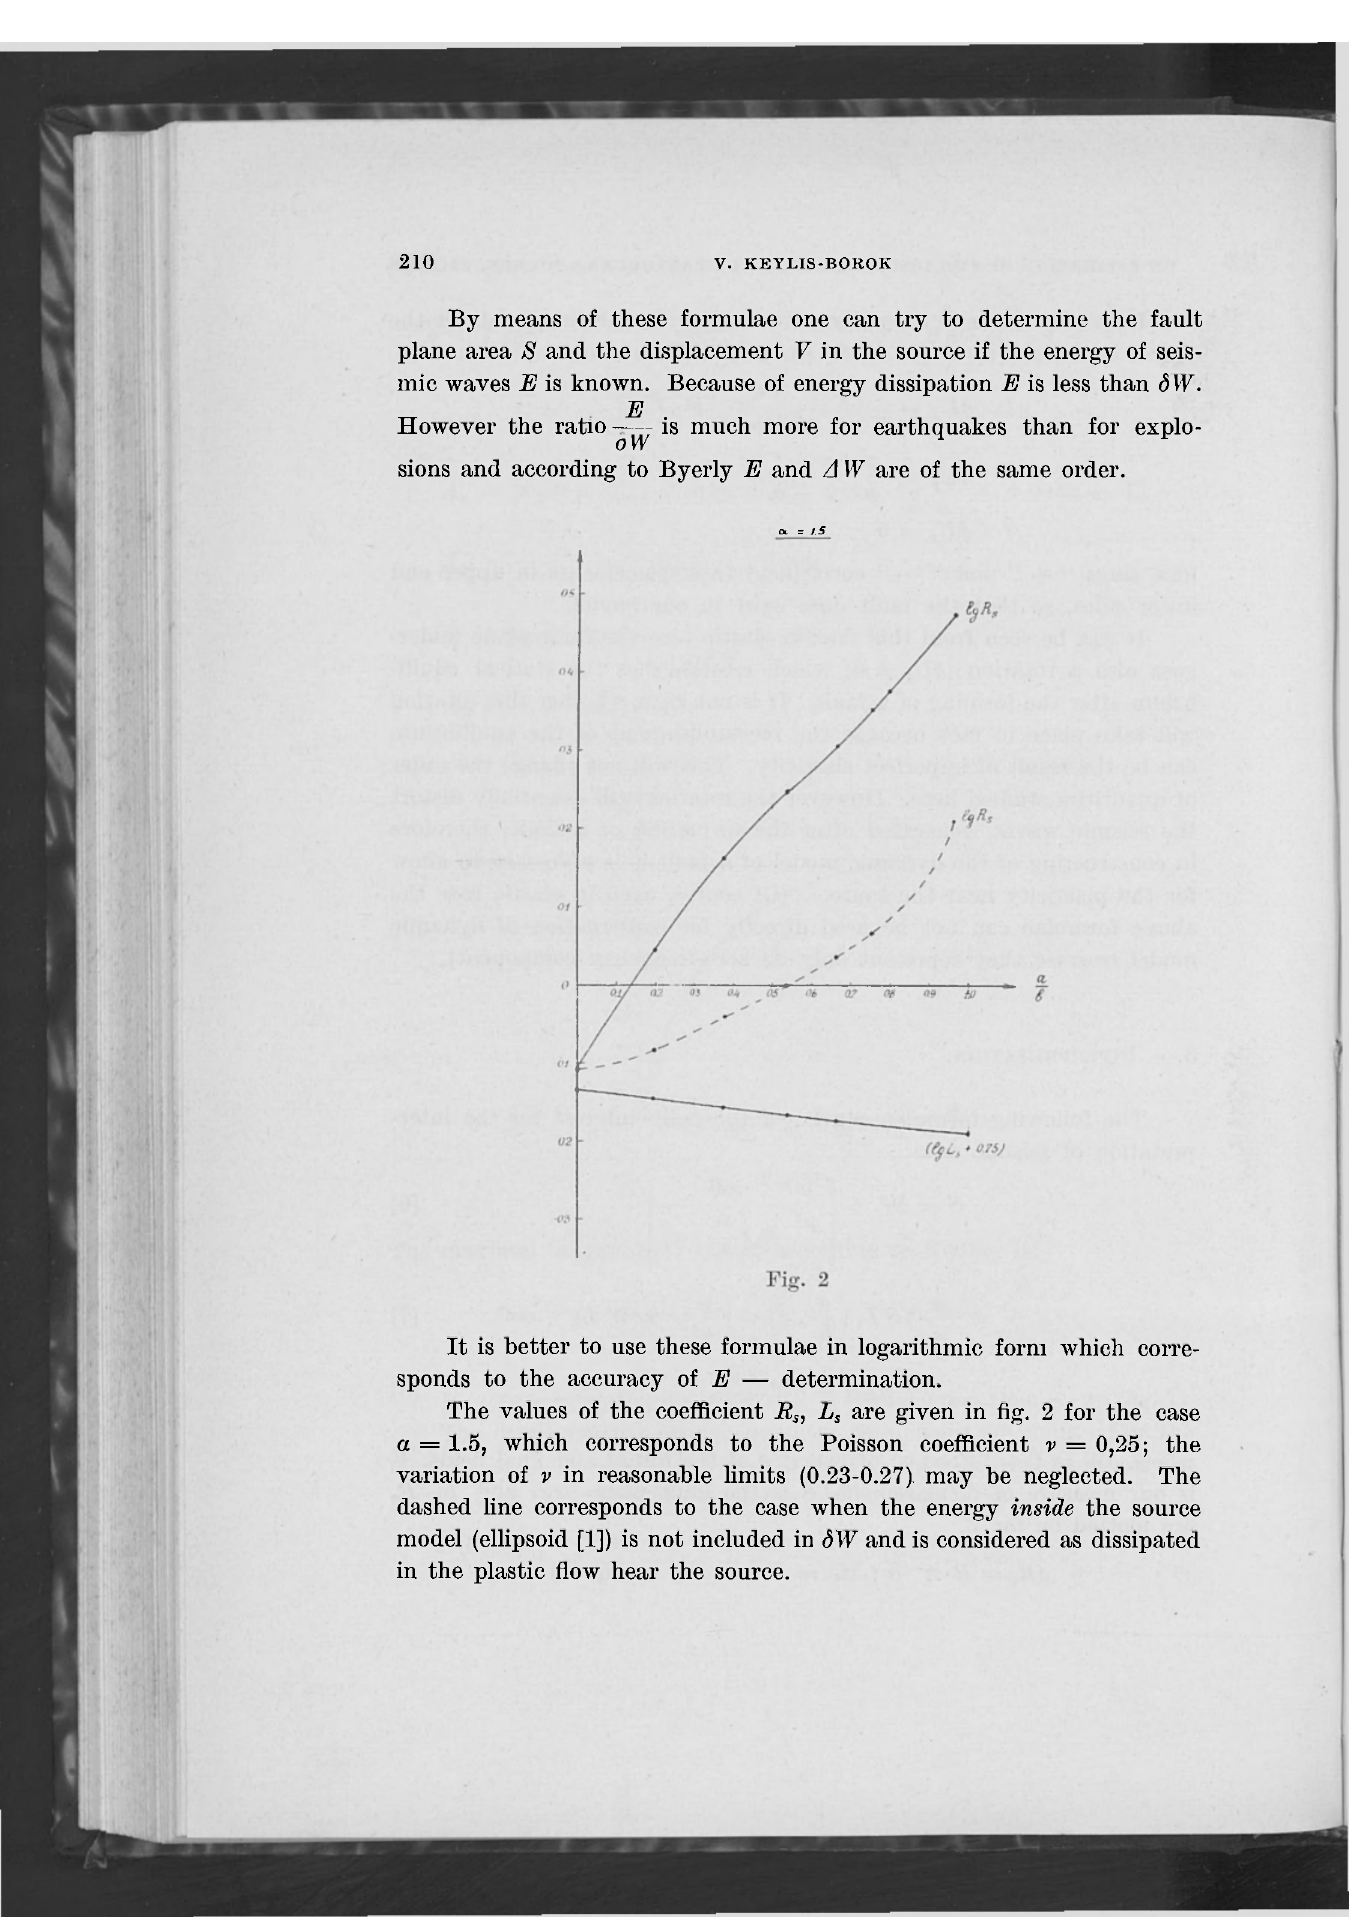
dashed line corresponds to the case when the energy inside the source model (ellipsoid [1]) is not included in ò W and is considered as dissipated in the plastic flow hear the